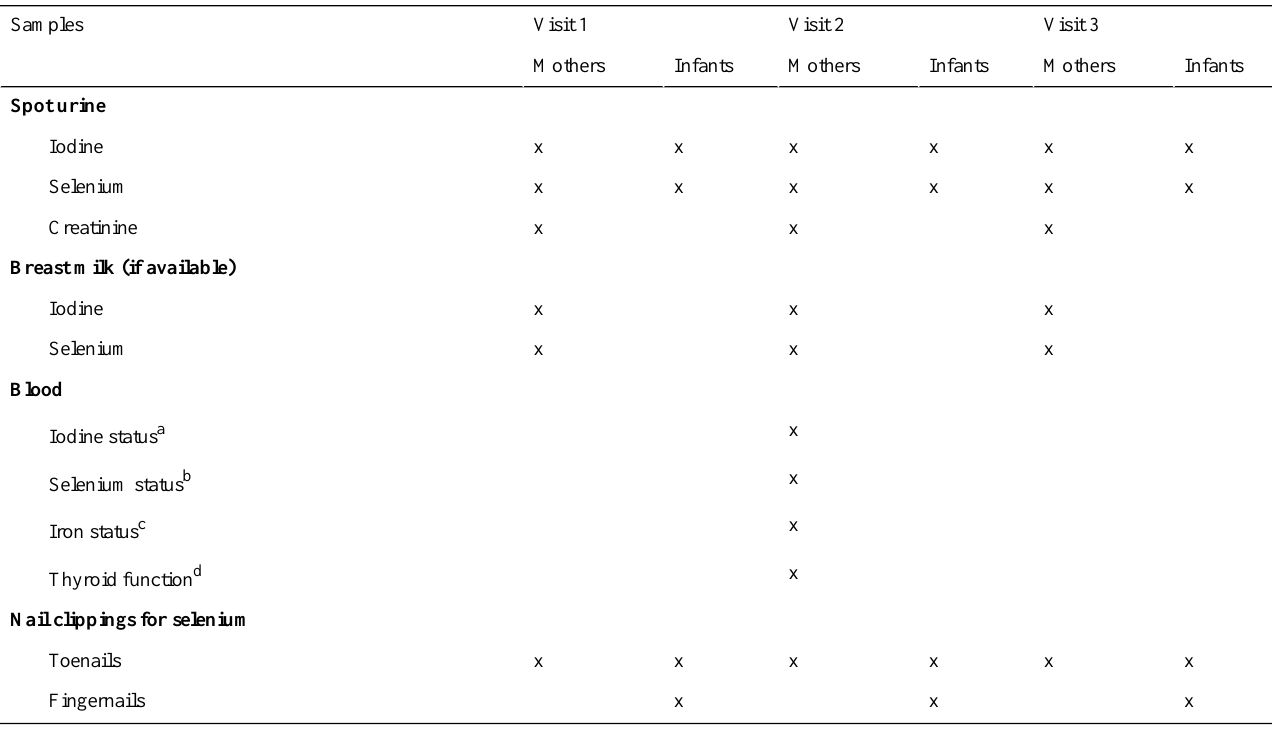
Table 2. Analysis from biological data collected at each study visit for the Mother and Infant Nutrition Investigation study cohort.